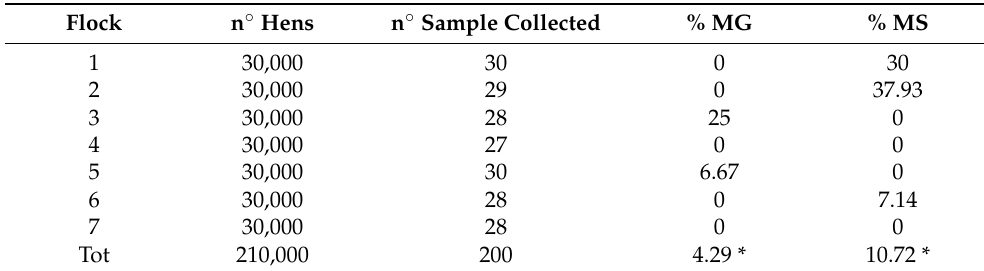
Table 2. Prevalence of MG and MG in commercial flocks (* average prevalence). Flock n ◦